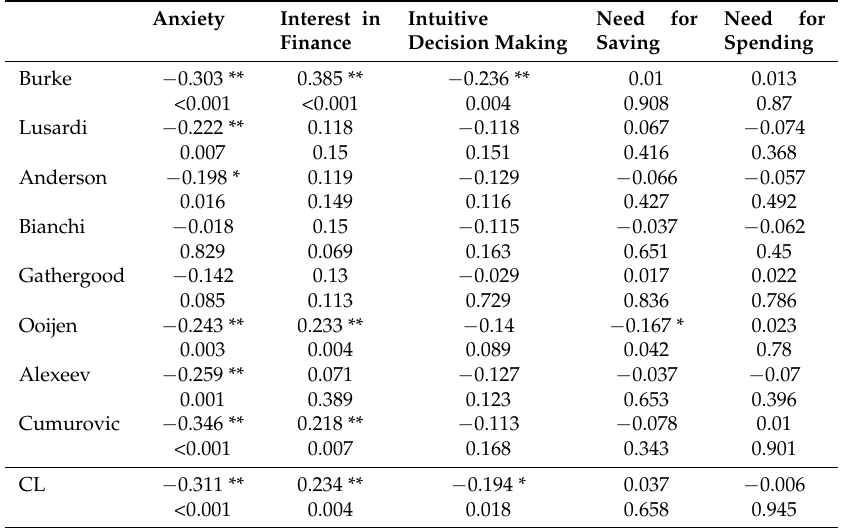
Table 10. Correlation of CL financial literacy with attitudes towards money (Fünfgeld and Wang